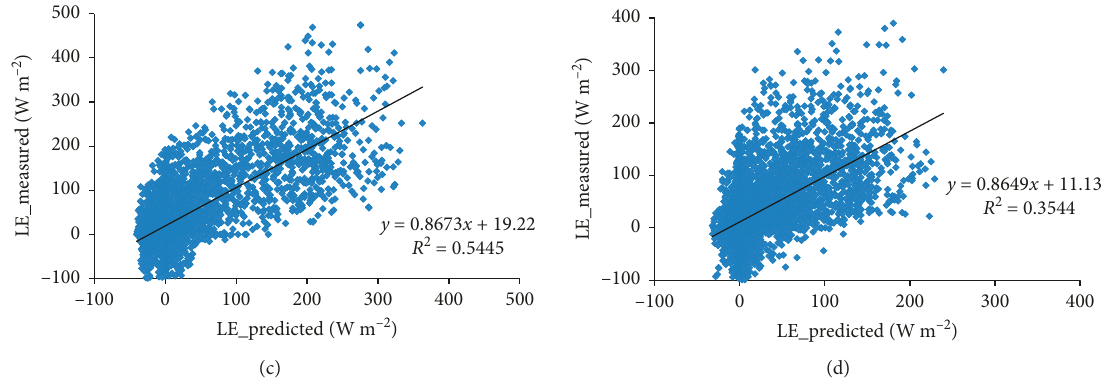
Figure 11: Comparisons between half-hourly measured and predicted LE (W · m − 2 ) for the season of (a) warm 2005, (b) cool 2005, (c) warm 2006, and (d) cool